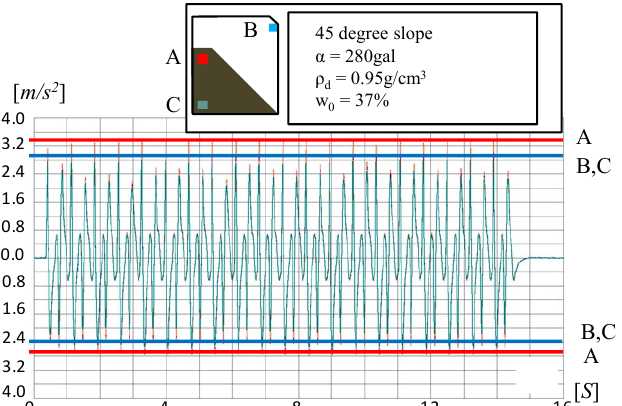
Figure 17. Variation in accelerations at the basement, crown of the embankment, and shaking table in earthquake-only experiments [6].